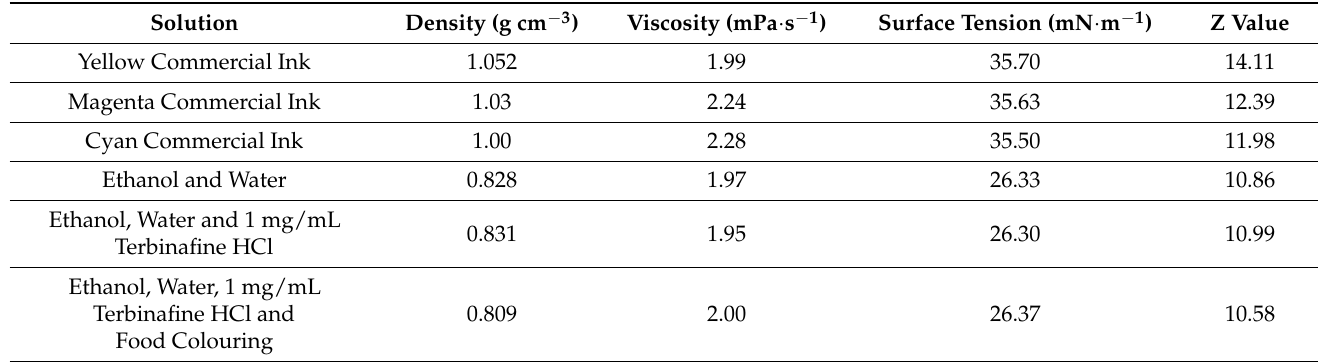
Table 1. Density, viscosity and surface tension values for various solutions. These values are critical for ensuring any inks developed will be printable with the two-dimensional inkjet